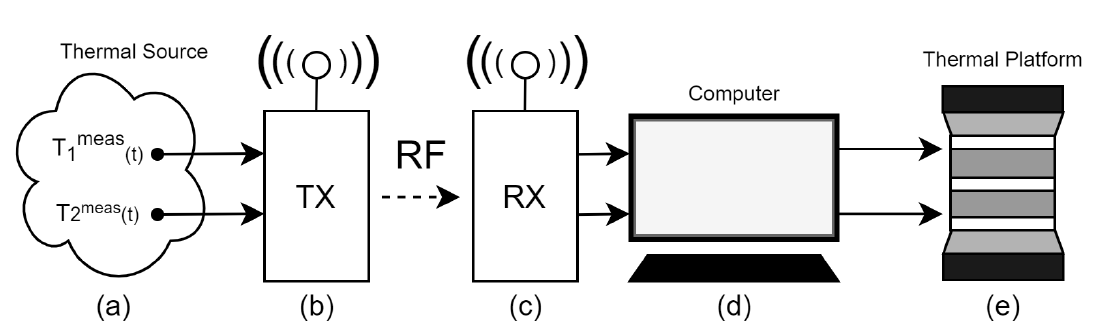
Figure 1. Proposed online emulation system. ( a ) Thermal source and the measurement device. ( b ) Transmitter. ( c ) Receiver. ( d ) Computer. ( e ) Thermal emulation